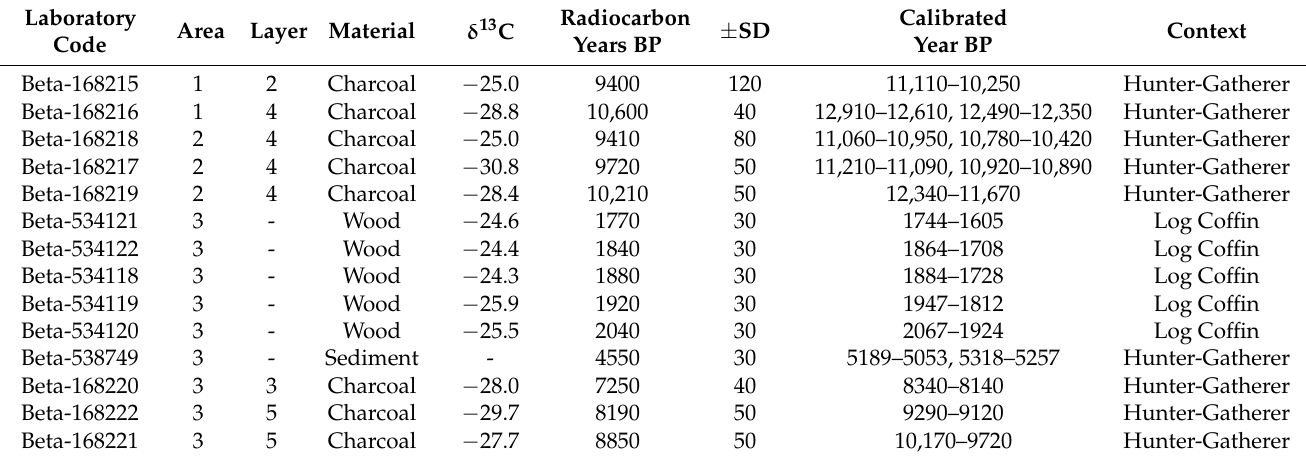
Table 1. Radiocarbon determinations from Ban Rai Rockshelter